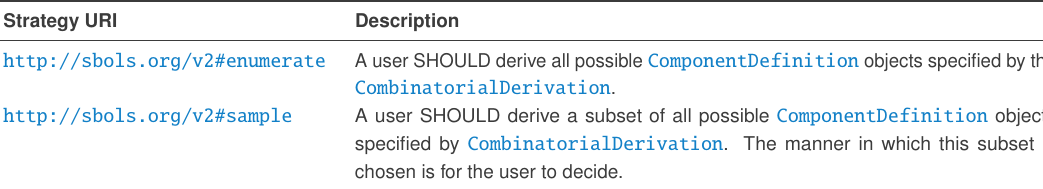
Table 15: REQUIRED URI s for the strategy